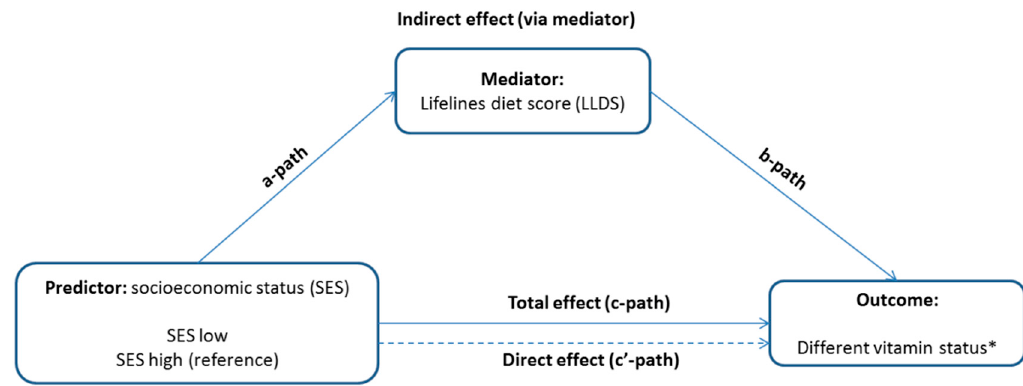
Figure 1. Conceptualized model of the Lifelines Diet Score as a mediator of the relationship between socioeconomic status (SES) and different vitamin status. * Vitamin status includes single- and multi-vitamin deficiency and insufficiency, and serum concentrations of the following vitamins: folic acid, vitamin B12, vitamin B6, vitamin D, vitamin E, vitamin K.